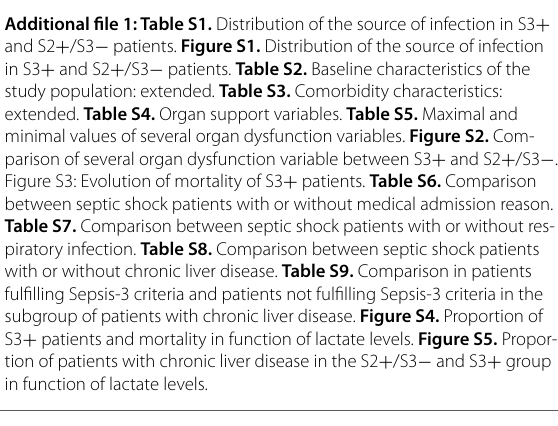
and S2 /S3 patients. Table S2. Baseline characteristics of the + + − study population: extended. Table S3. Comorbidity characteristics: extended. Table S4. Organ support variables. Table S5. Maximal and minimal values of several organ dysfunction variables. Figure S2. Com- parison of several organ dysfunction variable between S3 and S2 /S3 . + + − Figure S3: Evolution of mortality of S3 patients. Table S6. Comparison + between septic shock patients with or without medical admission reason. Table S7. Comparison between septic shock patients with or without res- piratory infection. Table S8. Comparison between septic shock patients with or without chronic liver disease. Table S9. Comparison in patients fulfilling Sepsis-3 criteria and patients not fulfilling Sepsis-3 criteria in the subgroup of patients with chronic liver disease. Figure S4. Proportion of S3 patients and mortality in function of lactate levels. Figure S5. Propor- + tion of patients with chronic liver disease in the S2 /S3 and S3 group + − + in function of lactate